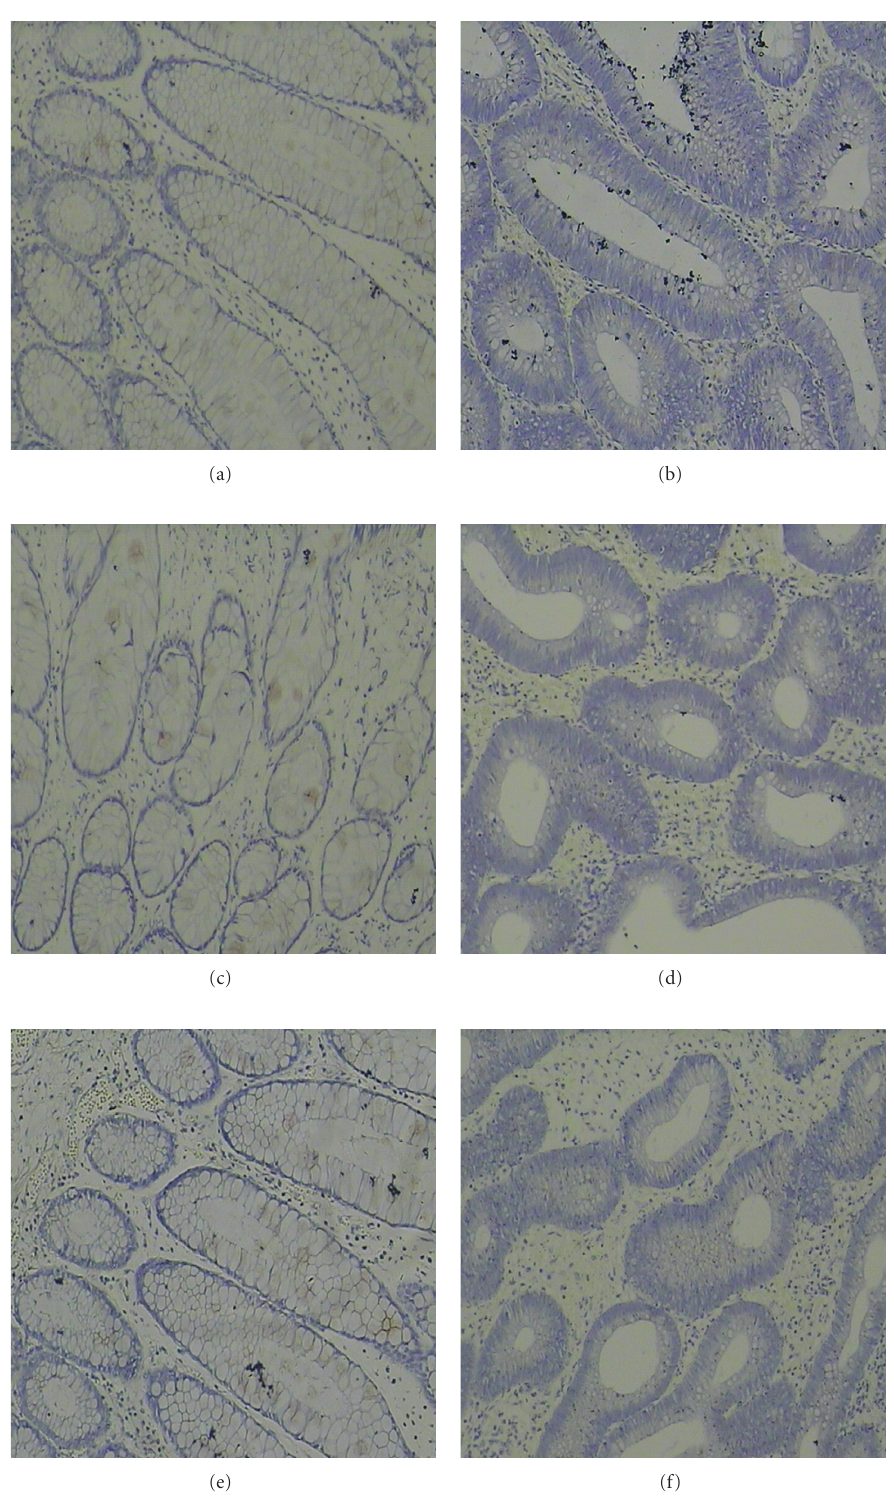
Figure 2: Expression of HIF-1 α , CXCR4, and VEGF in normal colonic tissue and hyperplastic polyps (HPP). HIF-1 α , CXCR4, and VEGF staining was negative in normal colonic tissue and HPP. Negative immunohistochemical staining of normal colonic tissue in (a) (HIF-1 α ), (c) (CXCR4), (e) (VEGF), respectively ( × 100). Negative immunohistochemical staining of HPP in (b) (HIF-1 α ), (d) (CXCR4), (f) (VEGF), respectively, ( ×